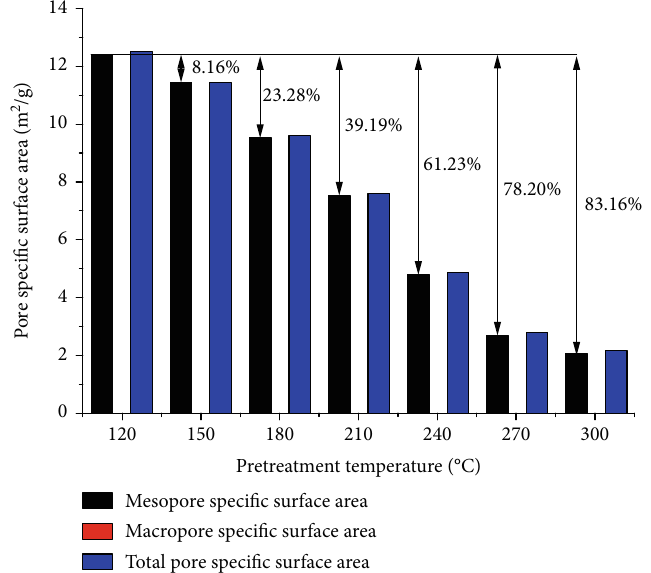
Figure 8: The dynamic change of meso- and macropore speci fi c surface area under various pretreatment